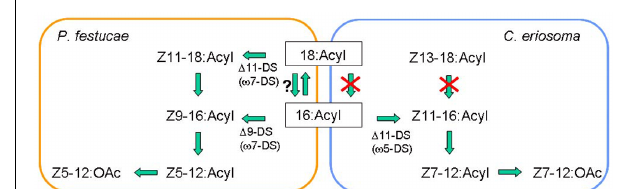
FIGURE 4 | Proposed biosynthetic pathways for the pheromone components, Z5-12:OAc and Z7-12:OAc, produced by the Plusiinae females. Experiments using deuterated fatty acids revealed that Z5-12:OAc was biosynthesized via ω 7-desaturation ( ω 7-DS) of 18:Acyl and 16:Acyl in the pheromone gland of Plusia festucae and Z7-12:OAc was biosynthesized via ω 5-desaturation ( ω 5-DS) of 16:Acyl in the pheromone gland of Chrysodeixis eriosoma .The β -oxidation systems for the pheromone biosynthesis of the two Plusiinae species were different.